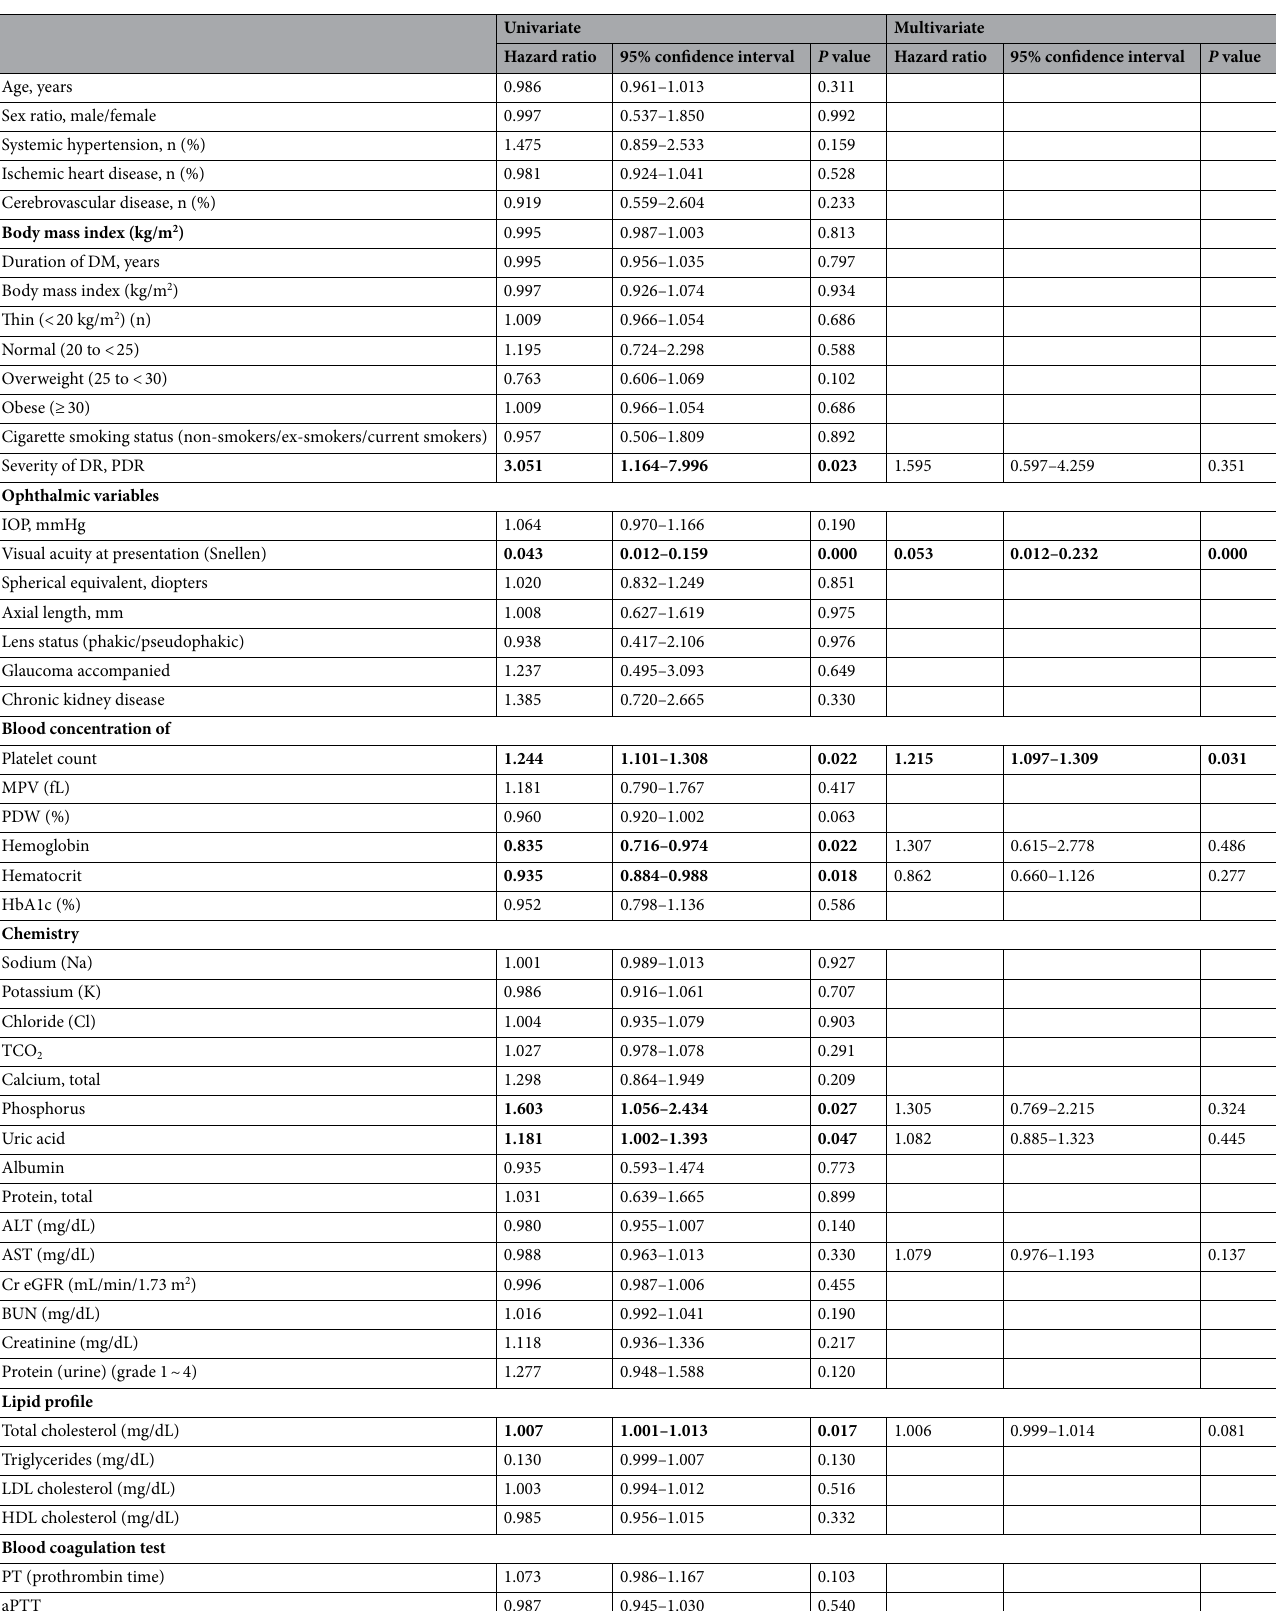
Table 2. Univariate and multivariate logistic regression analysis model data for progression of DR. Logistic regression analysis for systemic and ocular parameters in Progression group, using the Non-progression group as a reference. Bolded values represent significant, P <